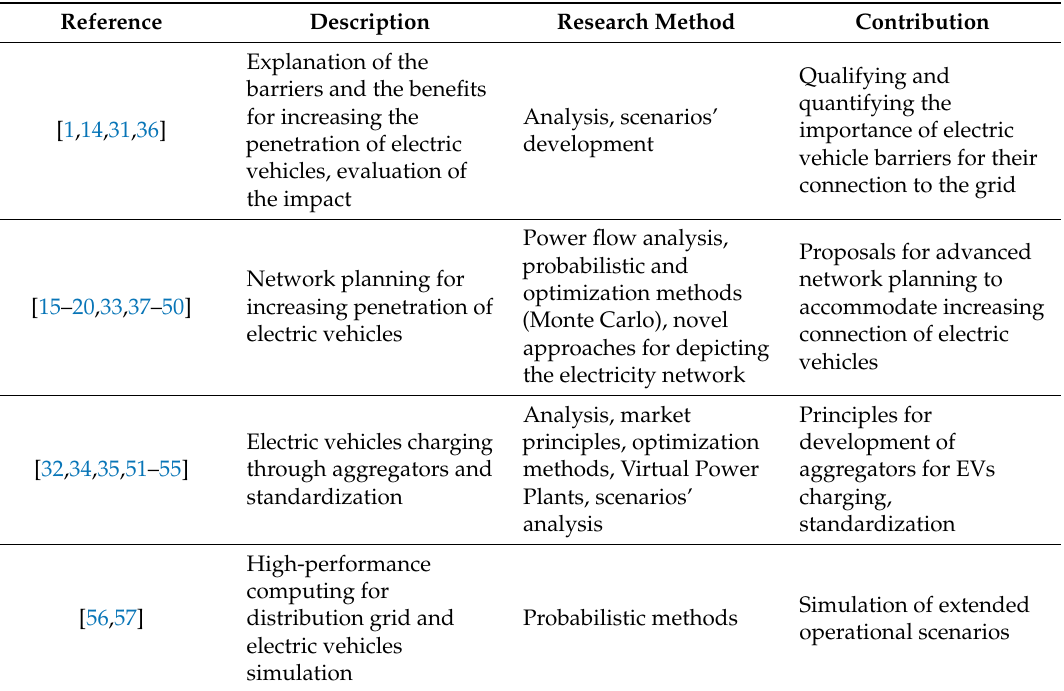
Table 1. Distribution networks protection